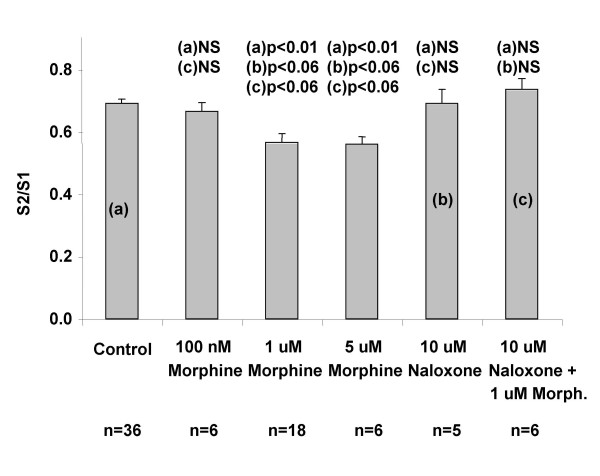
Effect of morphine on KCl-stimulted [3H]GABA release. The ratio of the integration of the peaks S2 over S1 was calculated for each elution profile. Morphine (0.1, 1 and 5 μM) and naloxone (10 μM) alone or together were perfused as described in figure 1 but naloxone perfusion was started one fraction earlier. Data represent averages ± SEM. Labels on the x-axis indicate concentration of drugs present during S2. Statistical difference was calculated using one-way ANOVA. The data indicates that 1 and 5 μM morphine caused a statistically significant 16% reduction of [3H]GABA release as compared to control (a) (p < 0.01). This effect of morphine was blocked by the antagonist naloxone (c) which had no effect on its own (b).